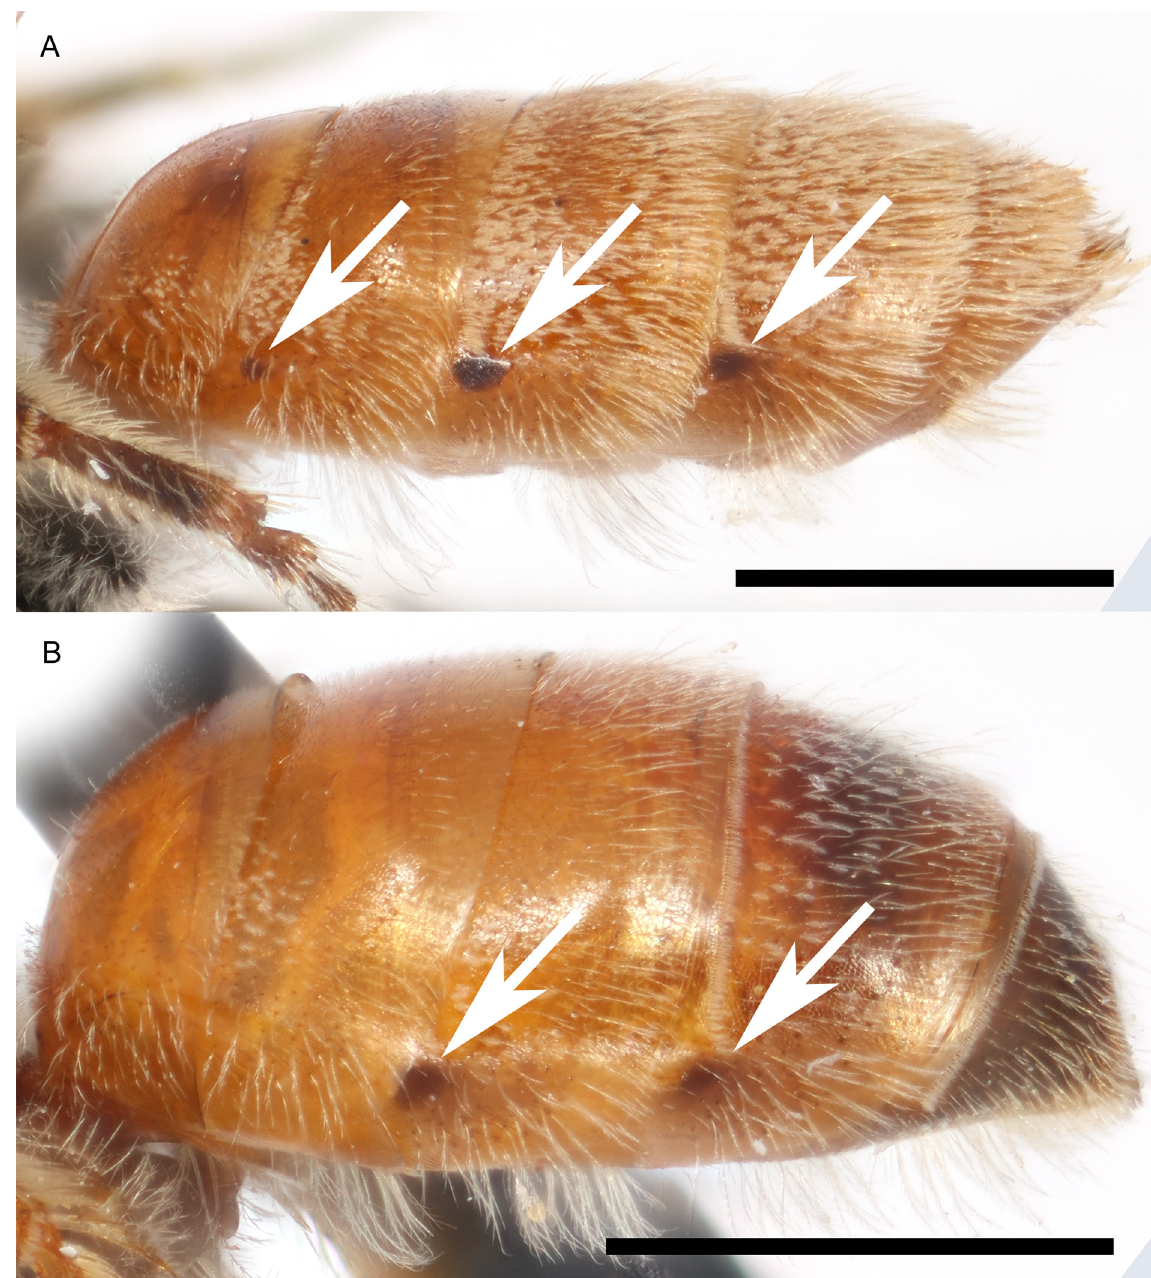
Fig. 105. Dark spiracular spots (arrows) on the metasoma. A . Lasioglossum ( D. ) pictum (Crawford, 1902), ♀, present on T2–4. B . L. ( D. ) meteorum sp. nov., ♀, present on T3–4 only. Scale bars: 1